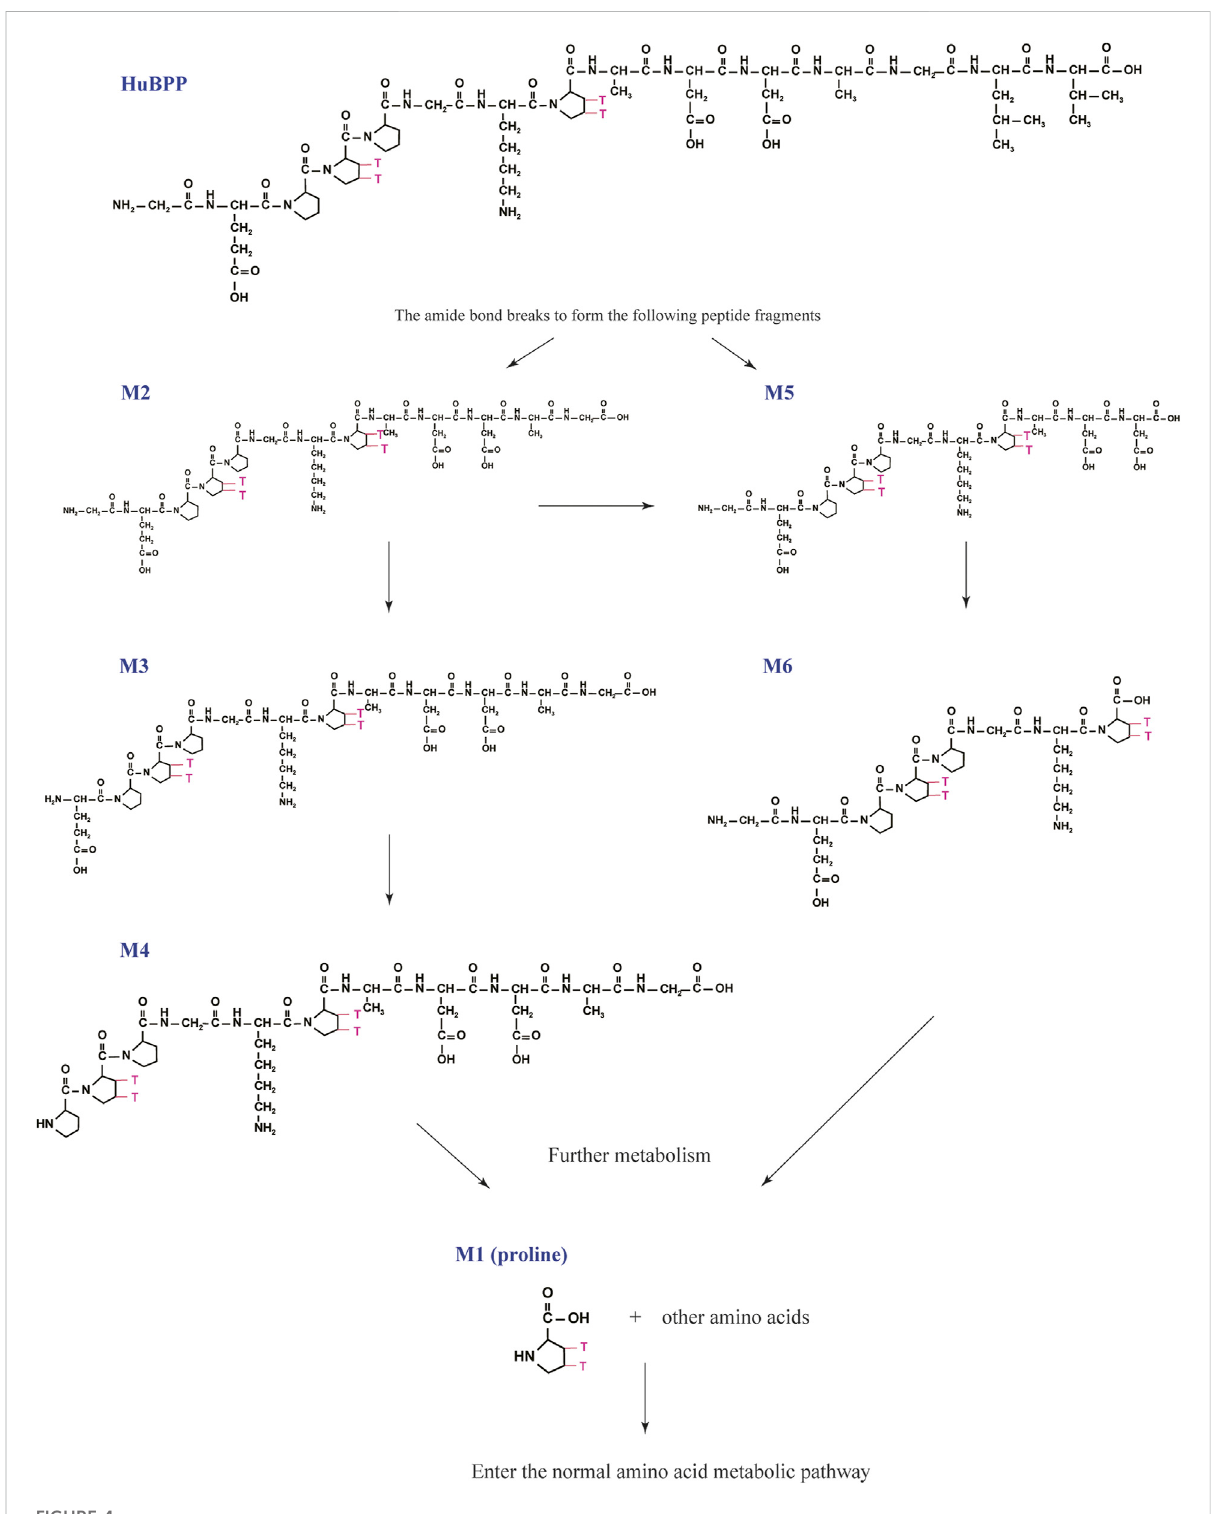
FIGURE 4 Speculated metabolic pathways of BPC157 in vivo . BPC157 gradually degraded into small molecular fragments and fi nally into single amino acids, which entered the metabolic circulation in vivo